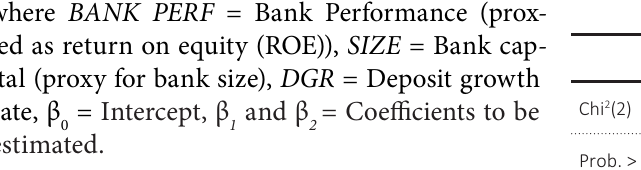
Table 1. Hausman test result for pre- and post- restructuring: